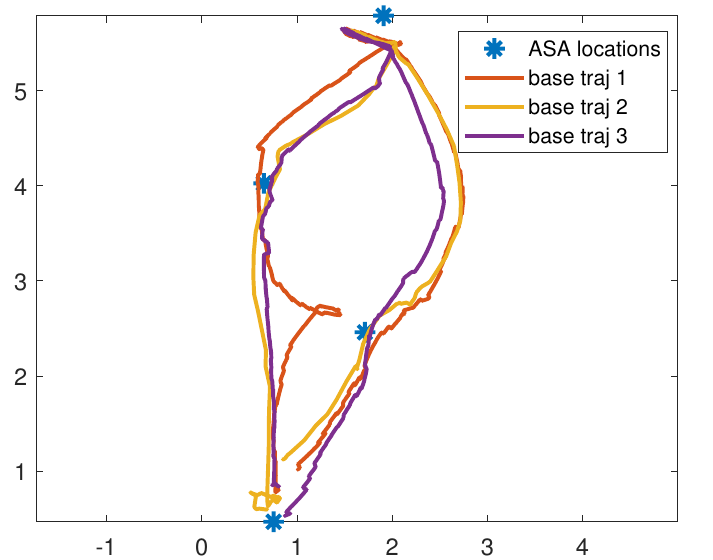
Figure 13. Plots of the robot base trajectories over three trials with respect to the ASA locations for the case of an obstacle between ASAs 1 and 2. The robot moves to the right of the obstacle to avoid it.